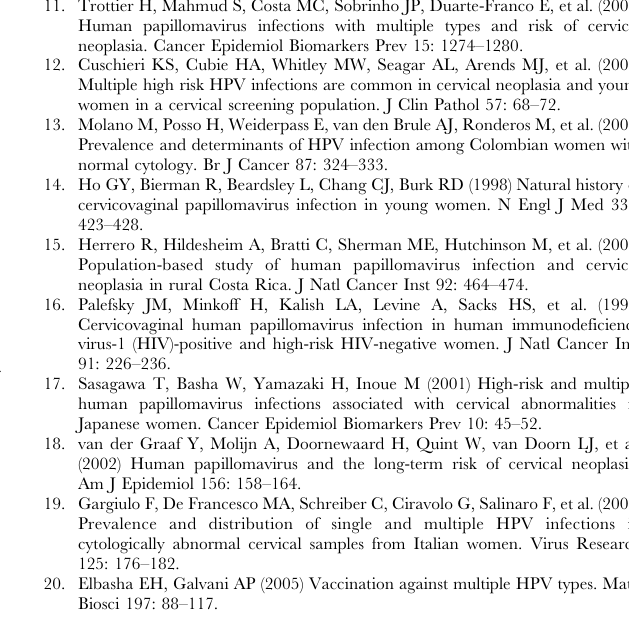
Figure S3 Testing specificity of HPV DNA genotyping